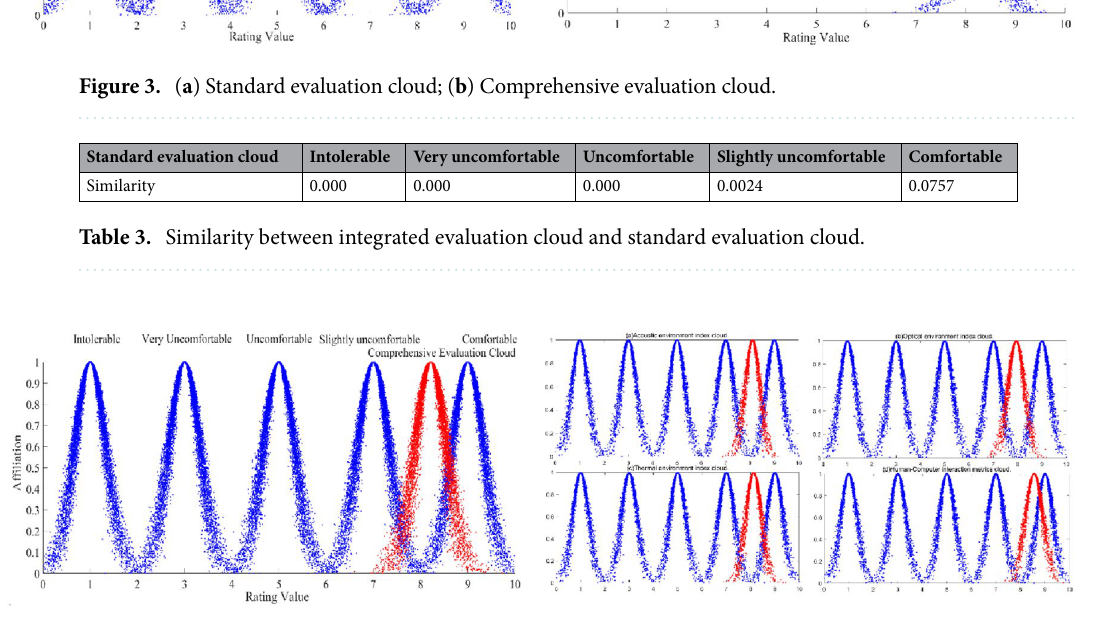
Figure 4. ( a ) Comparison of each indicator evaluation cloud with standard evaluation cloud. ( b ) Comparison between each indicator evaluation cloud and standard evaluation